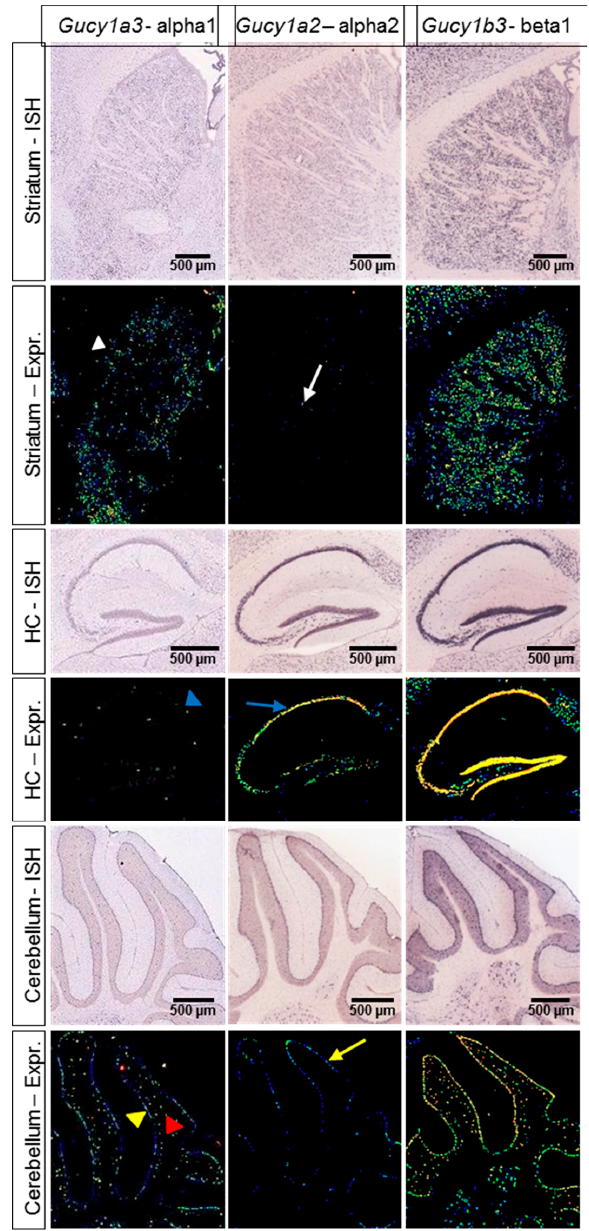
Figure 5. Expression of NO-GC1 mRNA is prominent in striatum and cerebellum, while NO-GC2 mRNA is strongly expressed in the hippocampus. Representative pictures of in situ hybridization (ISH) experiments showing mRNA expression of NO-GC subunits in striatum, hippocampus (HC) and cerebellum of an adult C57BL/6 mouse. Pictures labeled with “ISH” represent the original ISH staining, while pictures labeled with “Expr.” represent a heat map representing the relative amount of the respective mRNA (blue dots indicate low expression, yellow dots indicate high expression). NO-GC1 expression was detected in striatum (white arrowhead) and in the Purkinje cell layer (yellow arrowhead) and granule cell layer (red arrowhead) of the cerebellum. In the hippocampus, NO-GC1 expression was very low to undetectable (blue arrowhead), while NO-GC2 expression was high (blue arrow). Weak NO-GC2 expression was observed in the striatum (white arrow) and Purkinje cell layer of the cerebellum (yellow arrow). Data is taken from the Allen mouse brain atlas [36]. Image credit: Allen Institute.